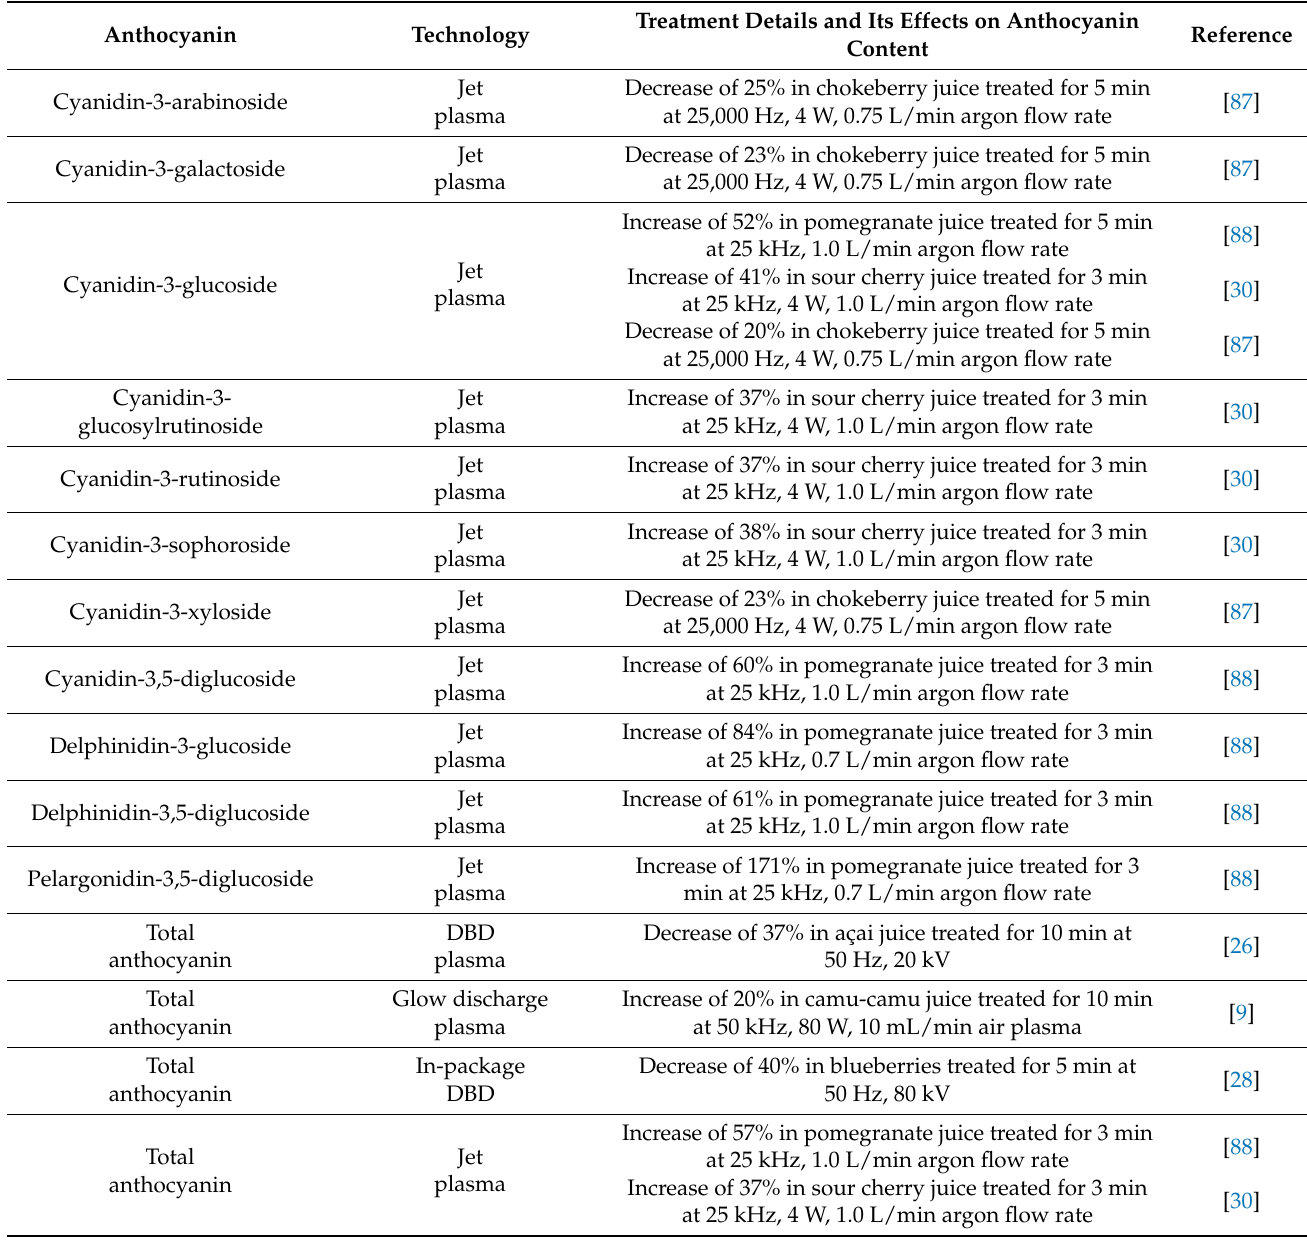
Table 5. Changes in anthocyanins induced by cold plasma